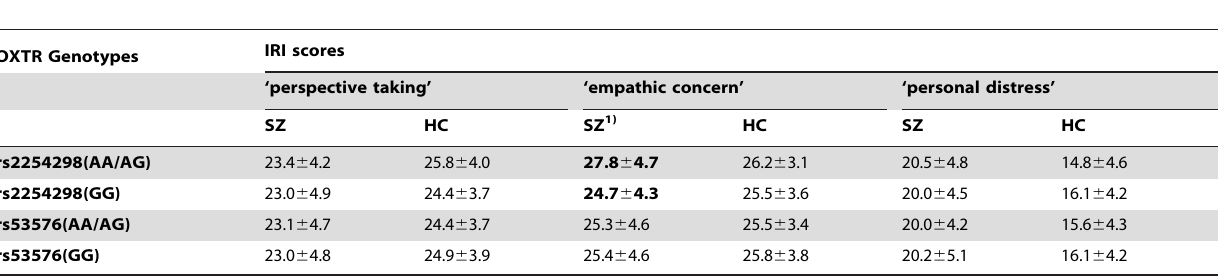
Table 3. Raw data of IRI scores (mean, SD) by OXTR rs2254298 and rs53576 genotypes in schizophrenia patients (SZ, n =145) and healthy controls (HC, n